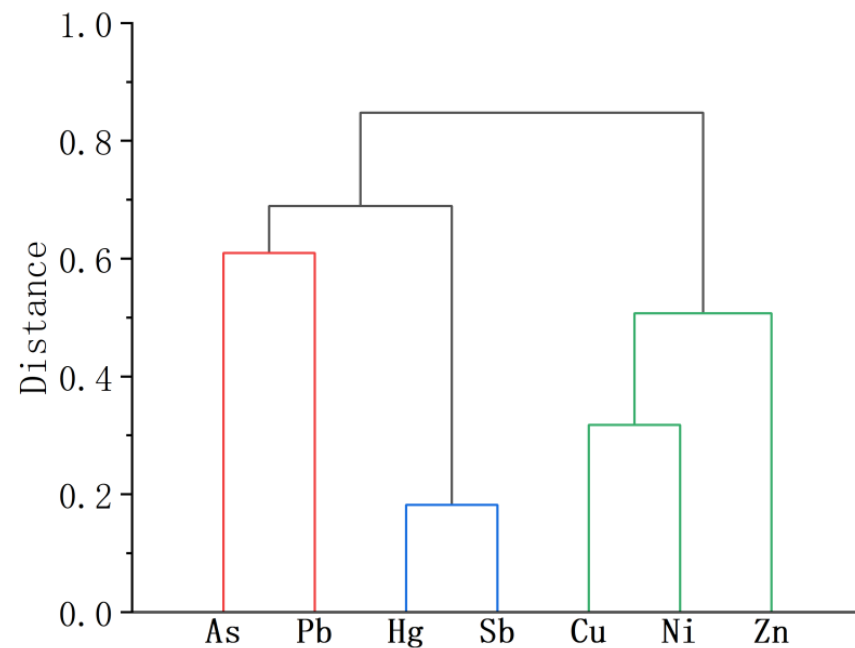
Figure 5. Dendrogram of HCA of the concentration of PTEs in the soil